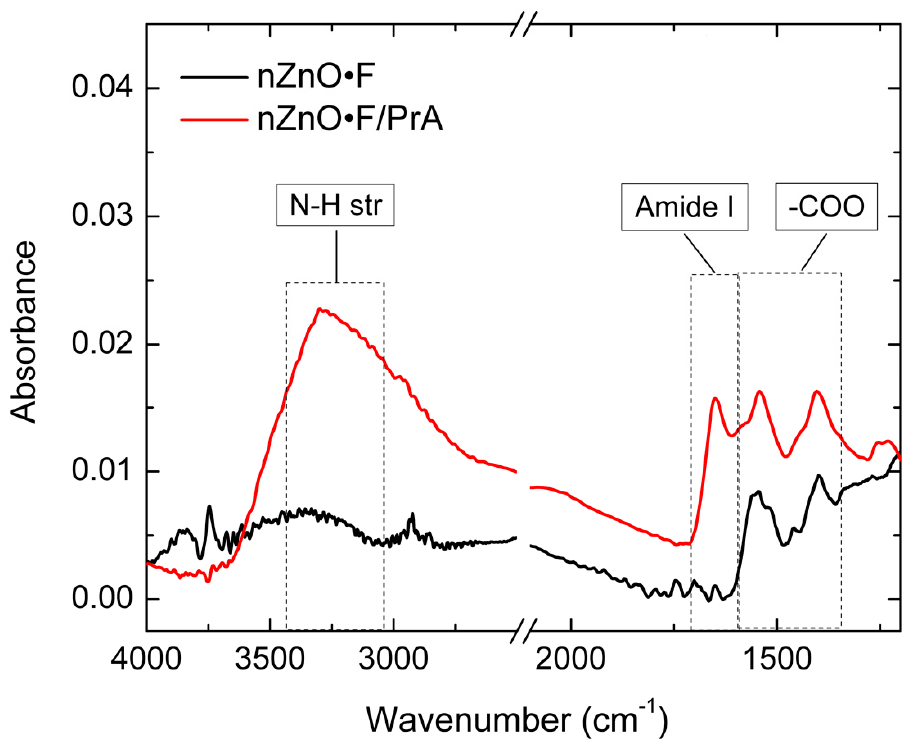
Figure 2. FTIR spectra of nZnO · F sample before (black line) and after (red line) functionalization with PrA.